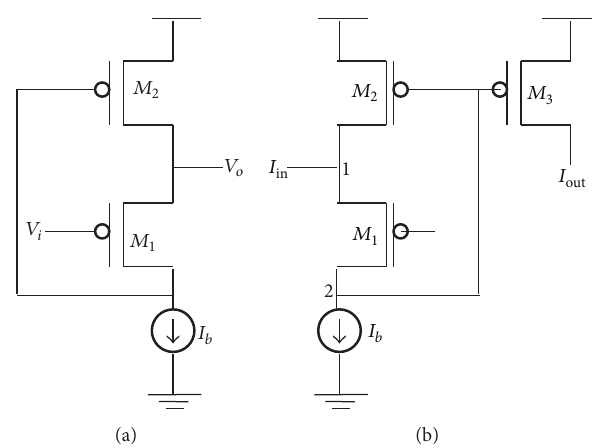
Figure 2: (a) An FVF cell; (b) FVF current sensor [19] .